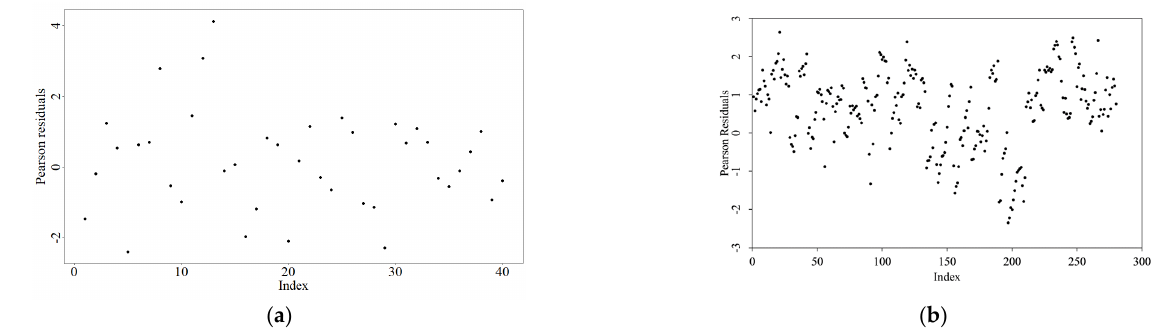
Figure 5. Pearson residuals: ( a ) for the Model 0; ( b ) for the Model 3. These plots suggest that the residuals appear to be randomly scattered around zero,